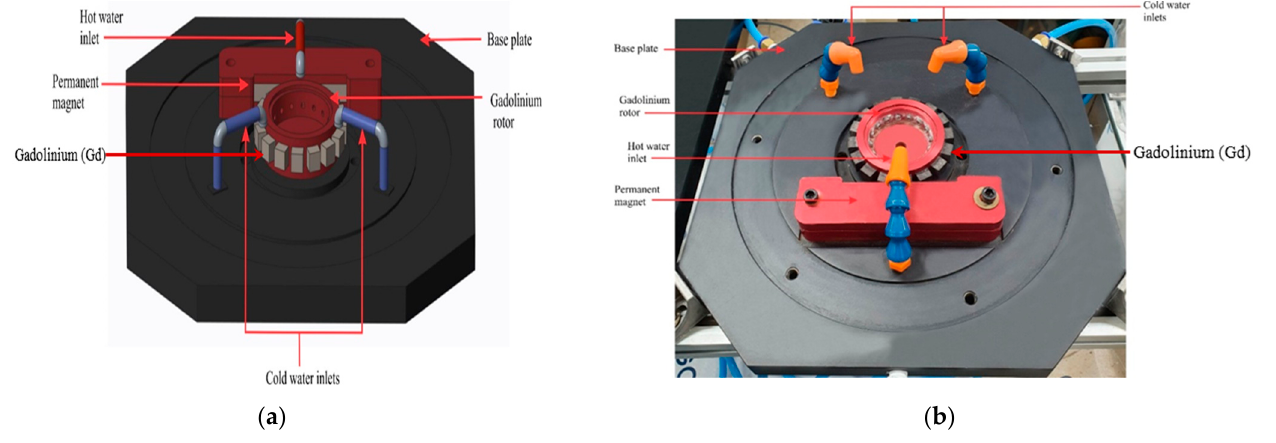
Figure 4. Schematic ( a ) and fabricated model ( b ) of thermomagnetic heat engine.